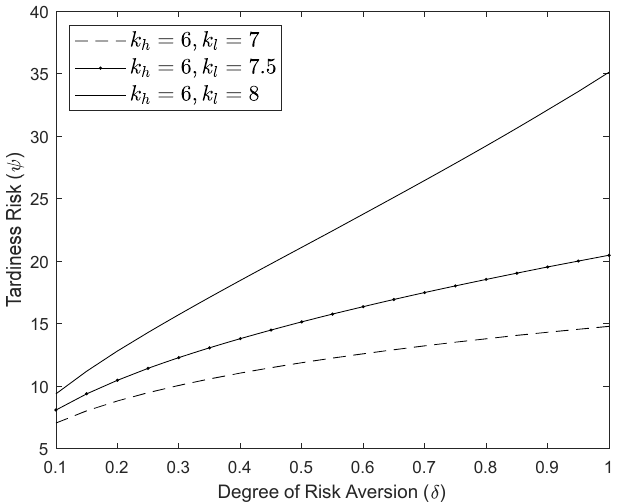
Fig. 6. The effect of degree of risk aversion on tardiness risk under asymmetric information